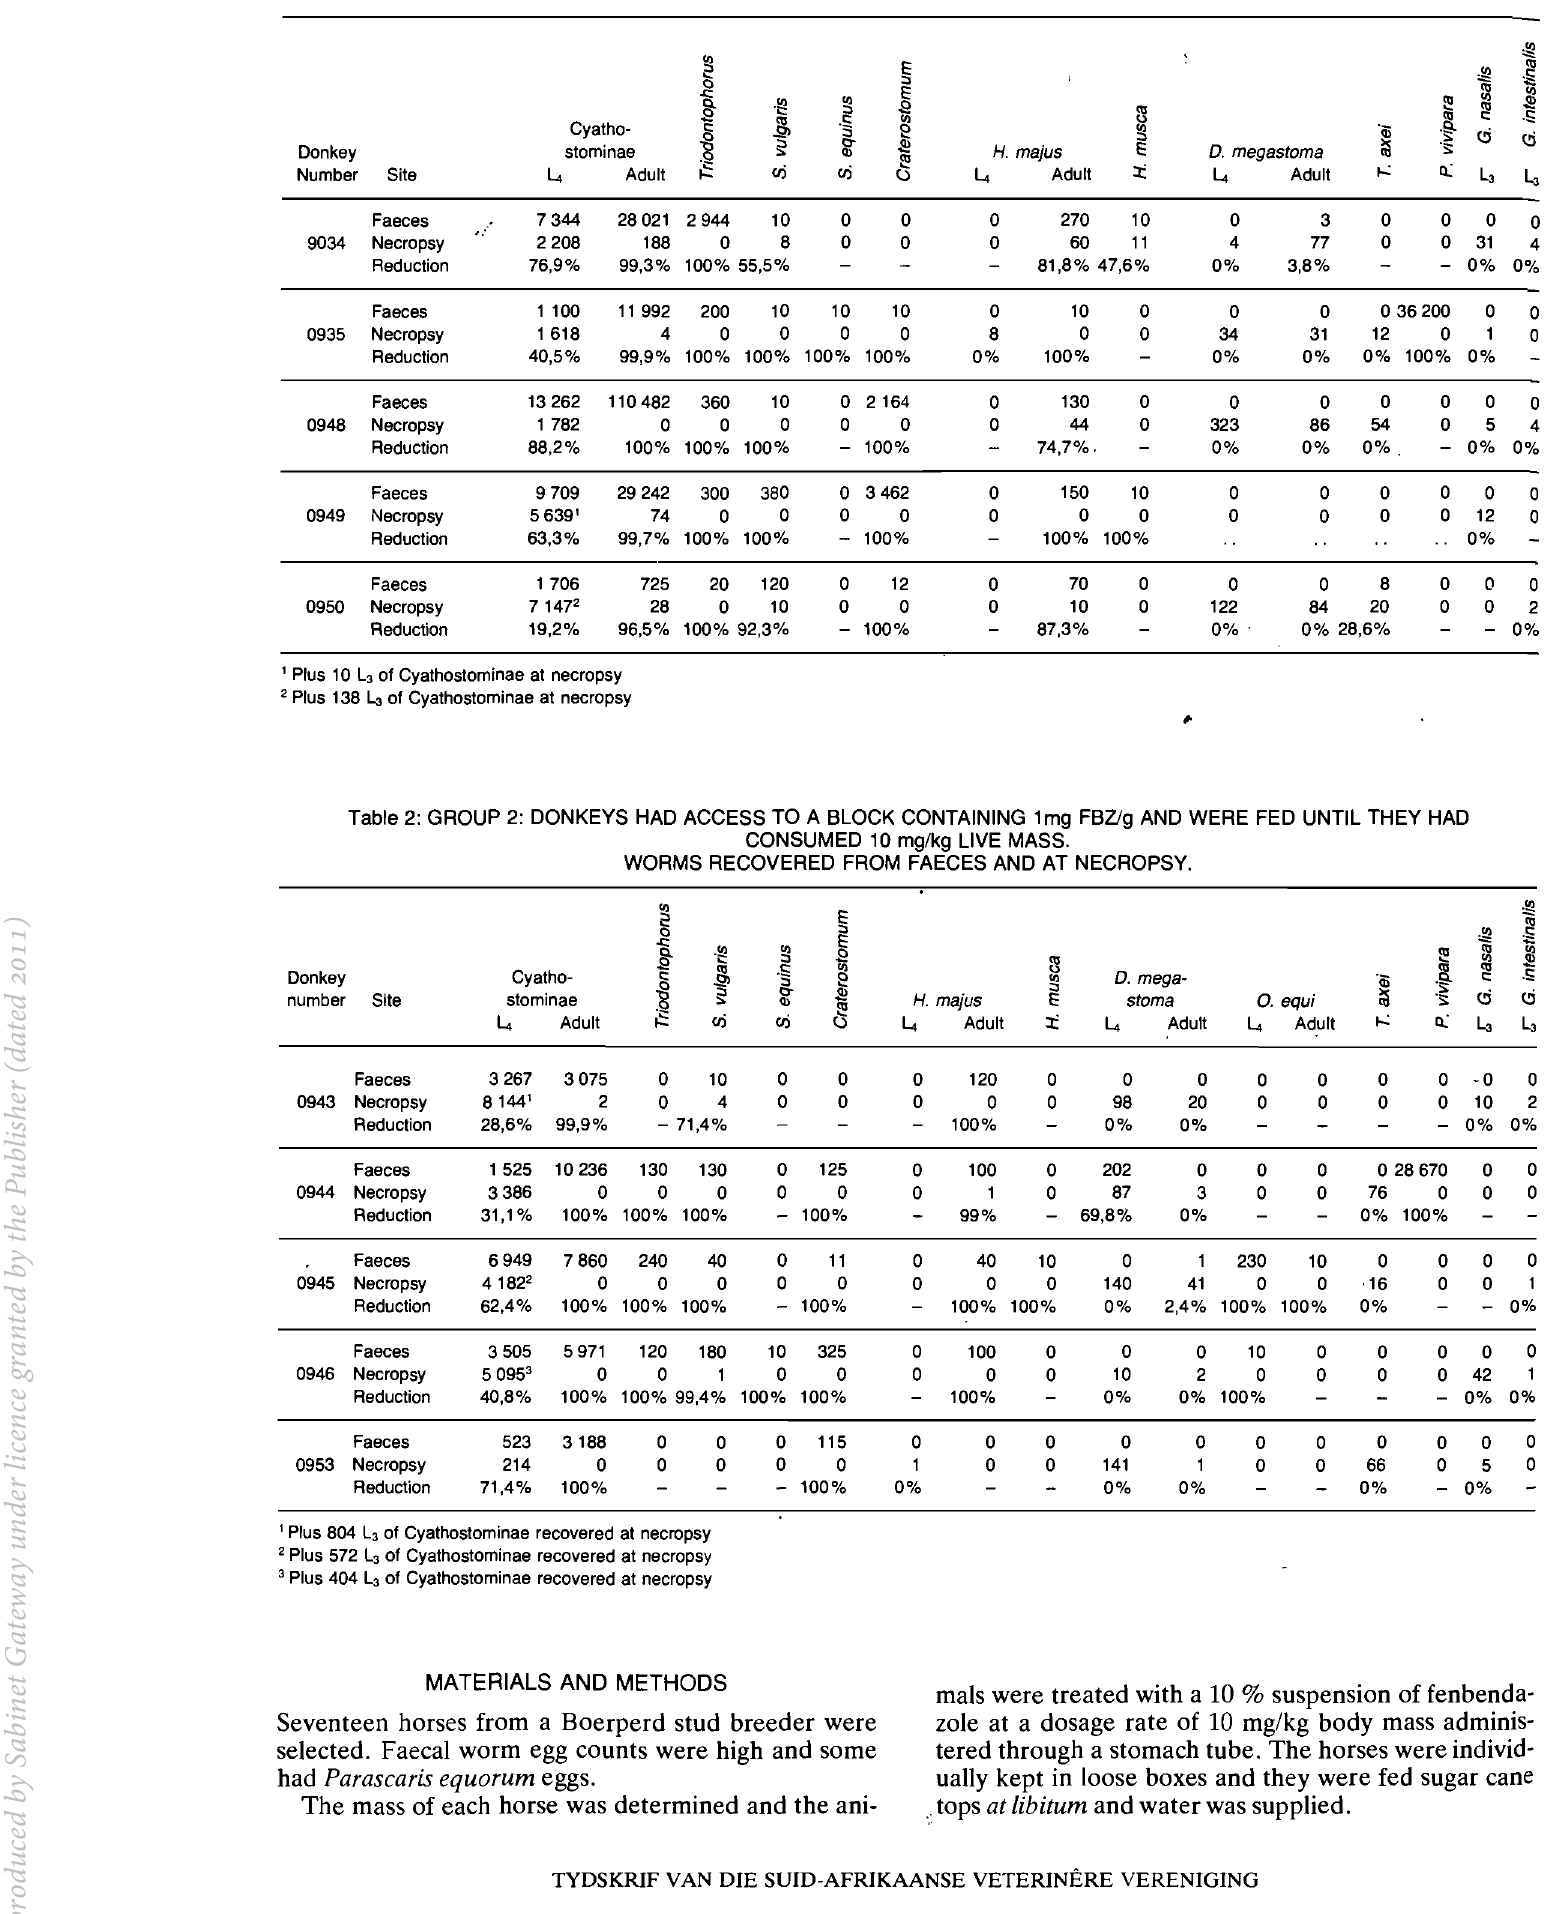
Table 1: DONKEYS GIVEN A SINGLE DOSE FBZ AT 10 mg/kg LIVE MASS. WORMS RECOVERED FROM FAECES AND AT NECROPSY